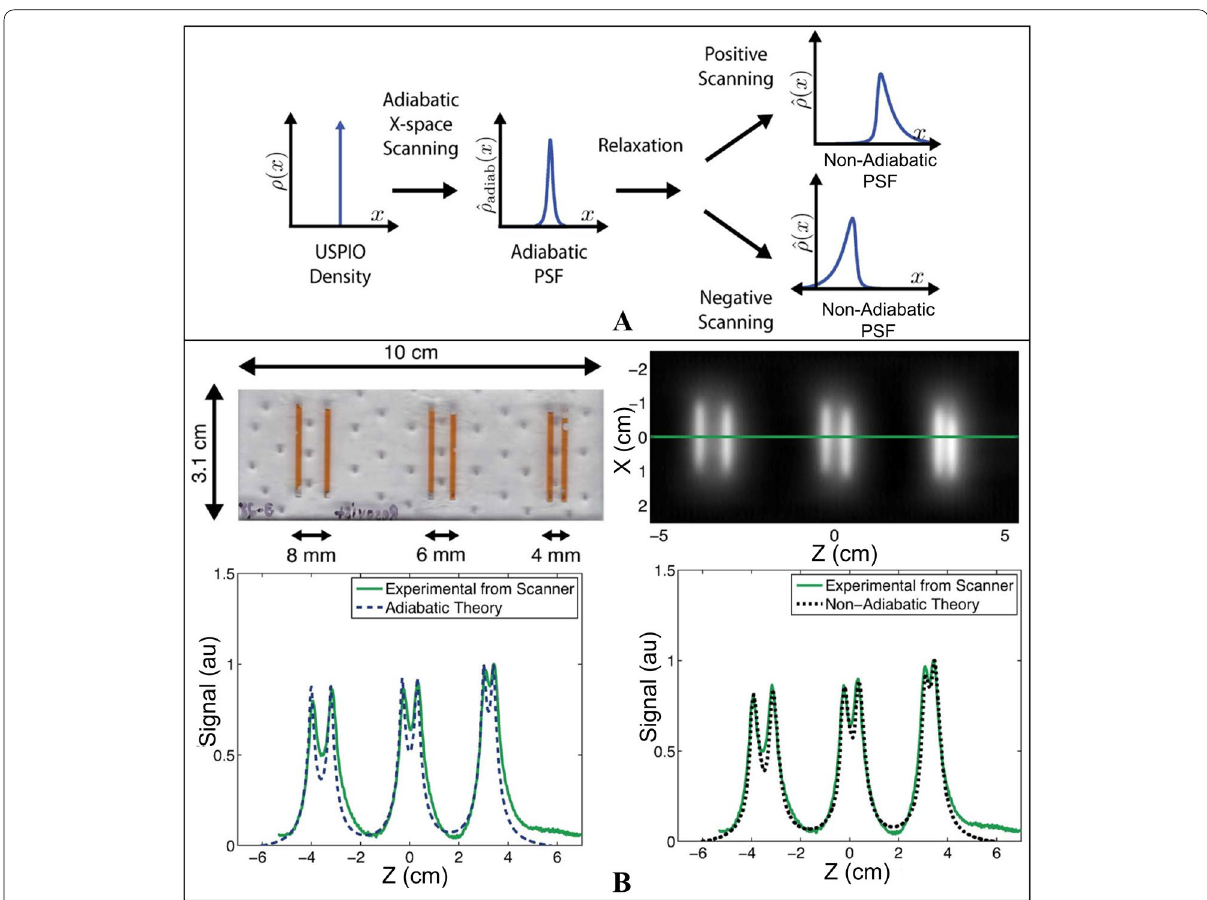
Fig. 5 A Comparison between adiabatic and nonadiabatic x-space scanning. The blurs caused by the relaxation effects occur in two scanning directions, which lead to nonidentical PSFs. B Experiments and reconstructed results of line phantoms with different spacing. For more images see ref.